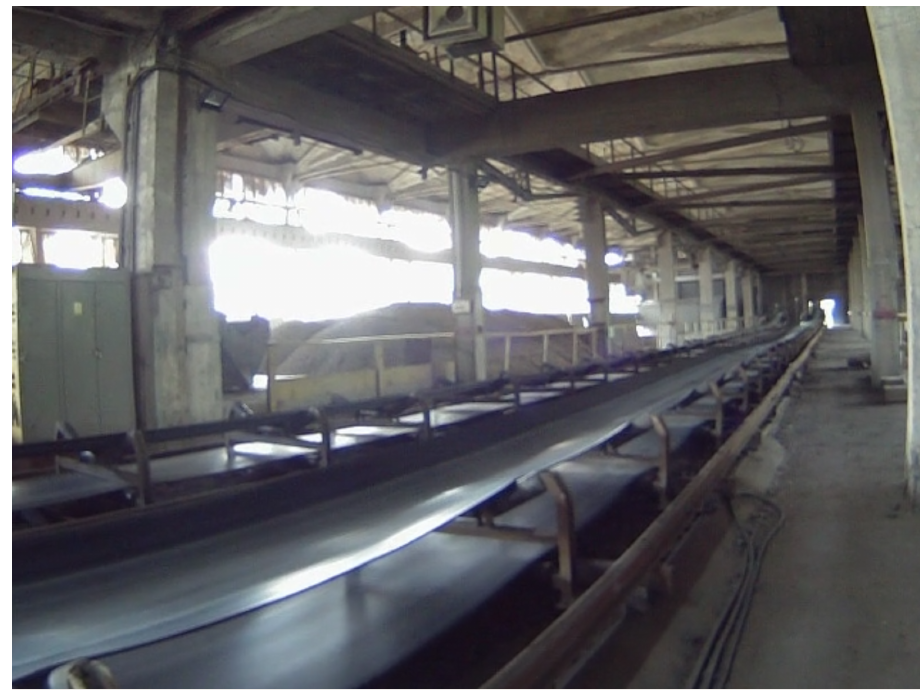
Figure 1. A general view of the belt